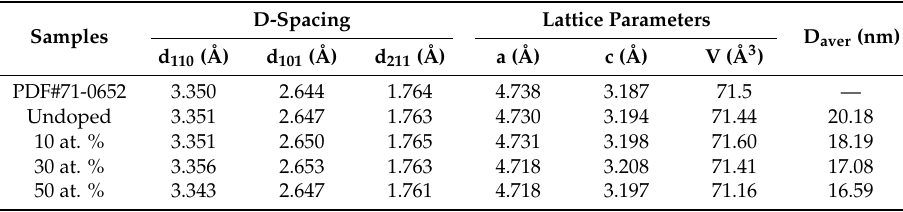
Table 1. Lattice information calculated from XRD of SnO 2 and FTO NPs.